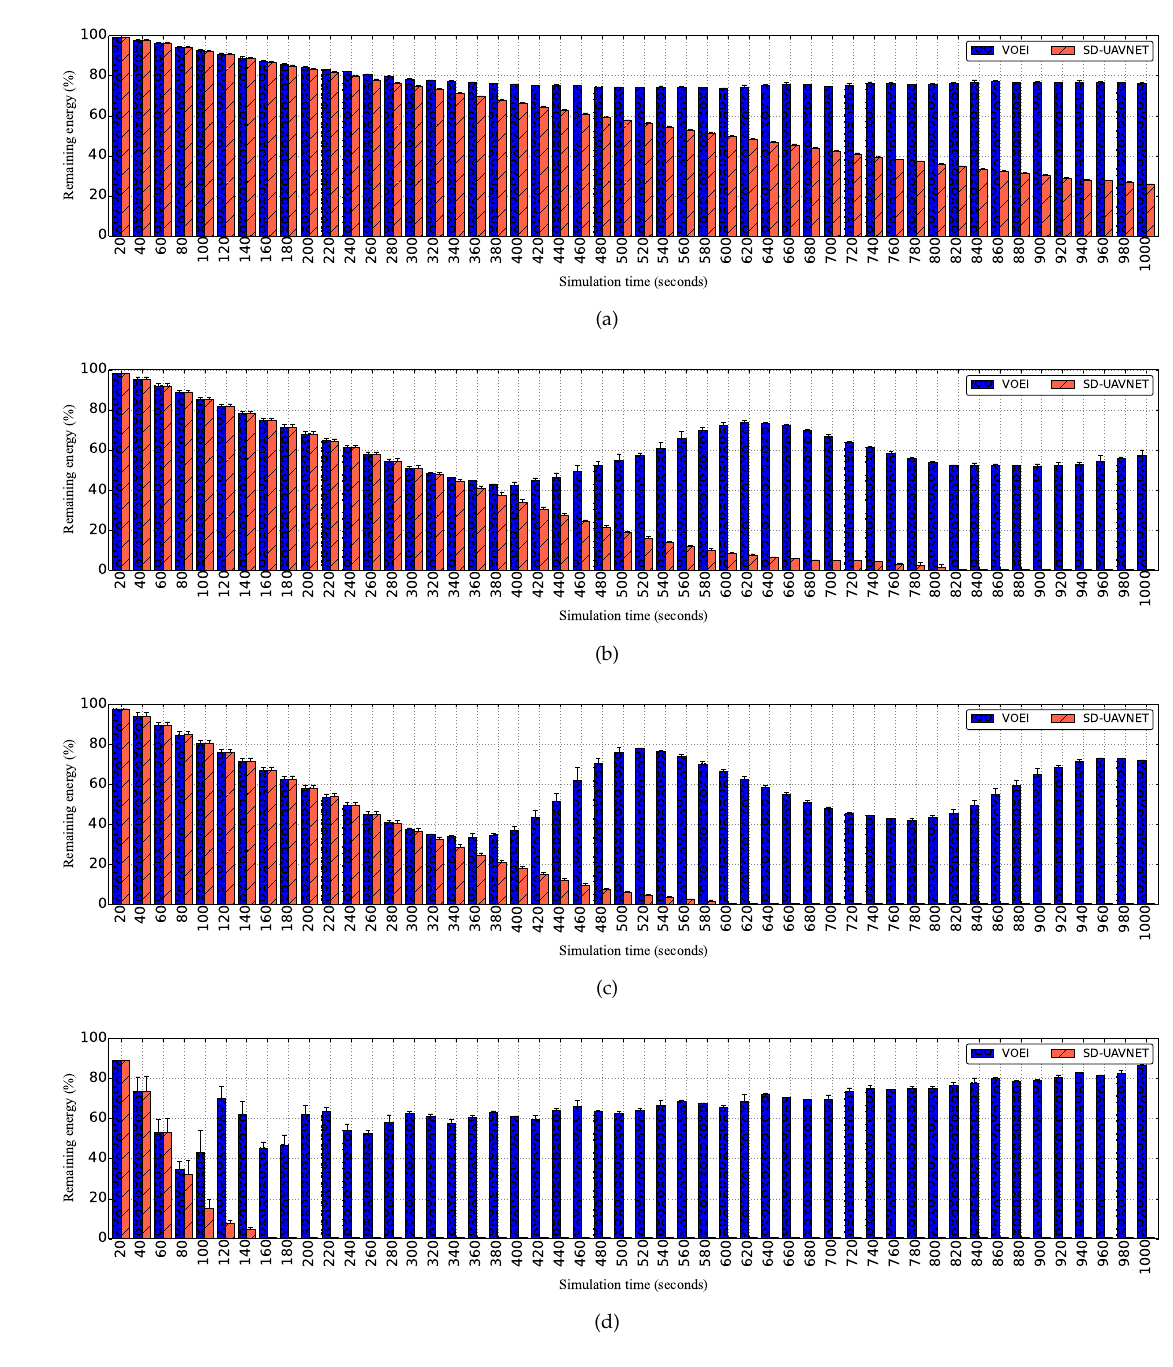
Figure 4. Remaining energy over time for UAVs flying with different speed limits. ( a ) UAV flying with speed raging from 1 to 5 m/s; ( b ) UAV flying with speed raging from 5 to 10 m/s; ( c ) UAV flying with speed raging from 10 to 15 m/s; ( d ) UAV flying with speed raging from 15 to 20